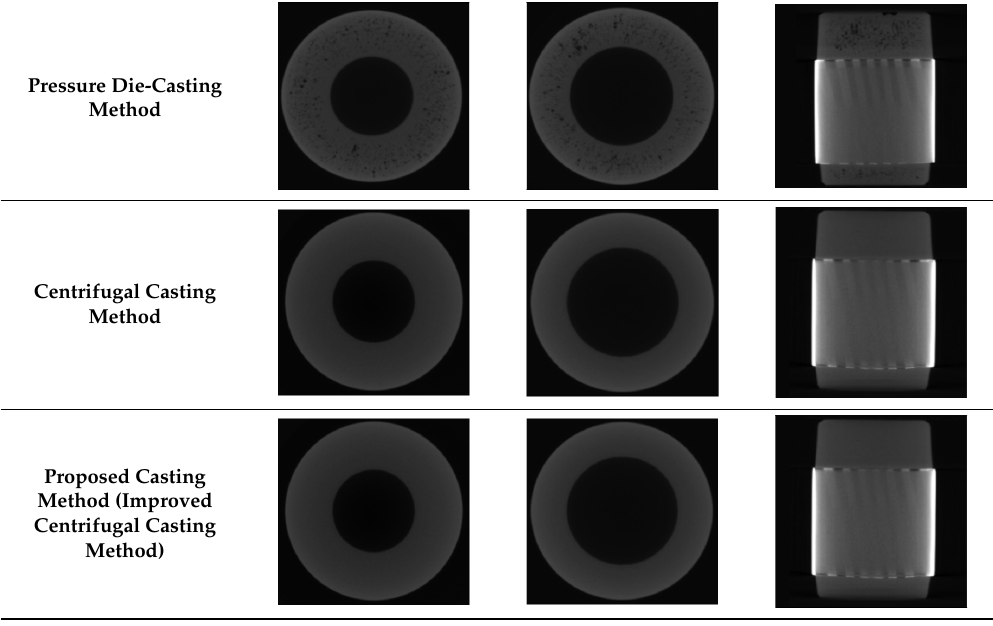
Table 2. The tomogram of the inside of each type of rotor, taken using an X-ray scan.